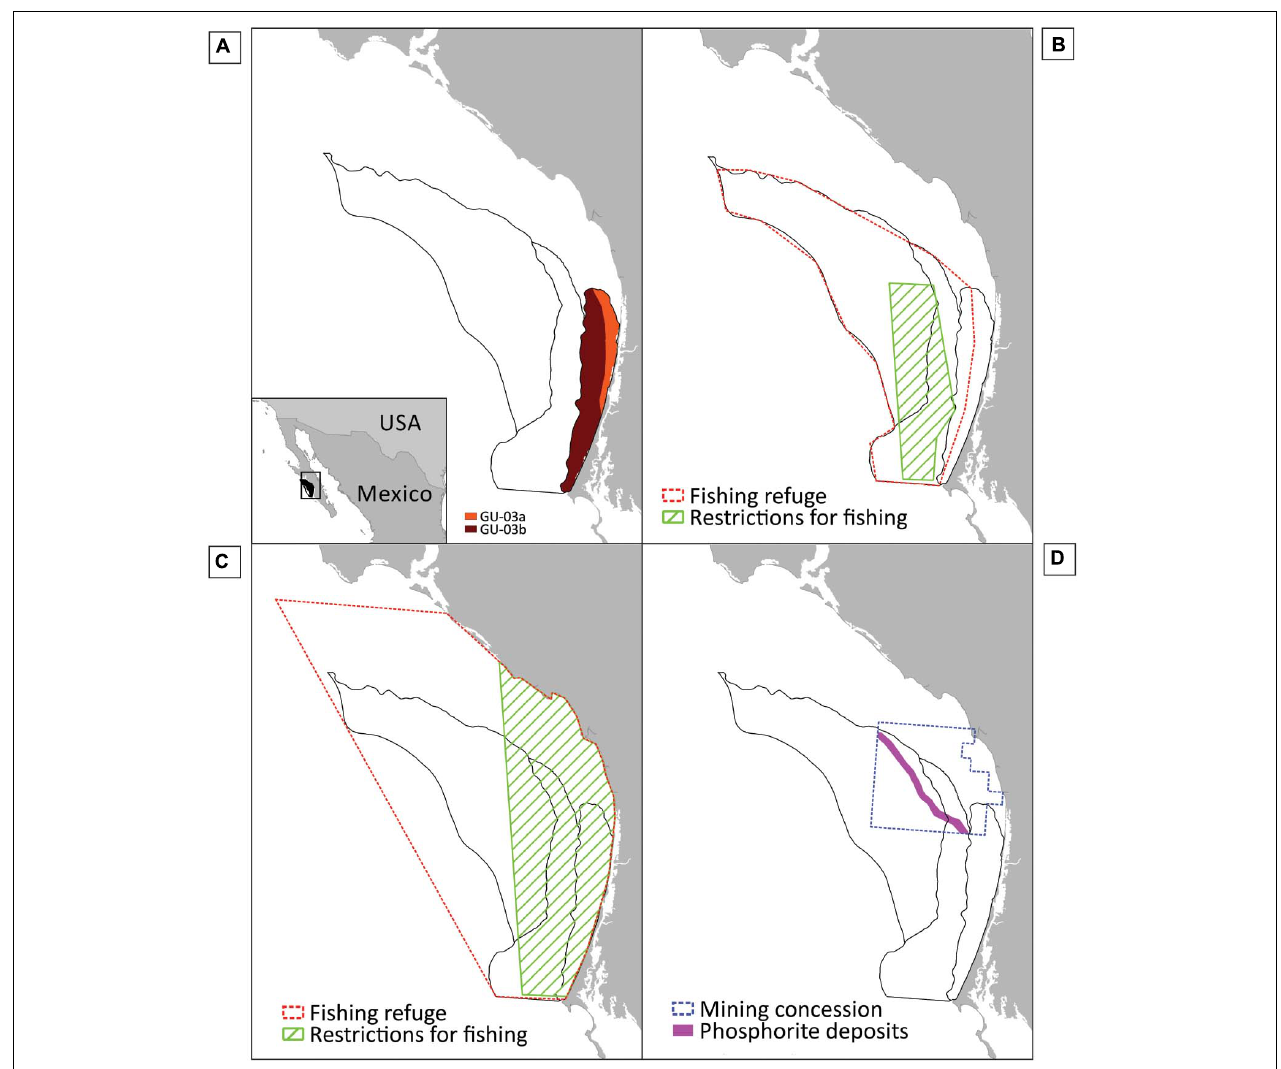
FIGURE 1 | (A) Location of Gulf of Ulloa and management zones (GU); (B) overlap between zones and the fishing refuge designed in 2015; (C) overlap between zones and the extended fishing refuge designed in 2016; (D) overlap between zones and the seafloor mining